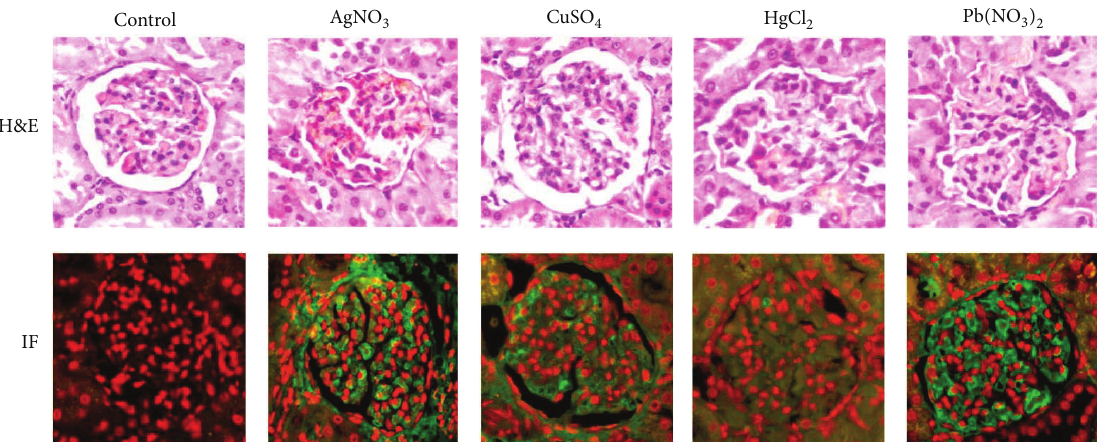
Figure 4: Renal histopathology. The top panel shows the control at the beginning of the trial and histology four weeks after each treatment by hematoxylin and eosin (H&E) staining. The bottom panel displays the glomerular direct immunofluorescence (IF) in the basal condition (control) and at the end of the trial. The immunofluorescence shows deposition of IgG in the glomerulus. Nuclei were counterstained using propidium iodide.